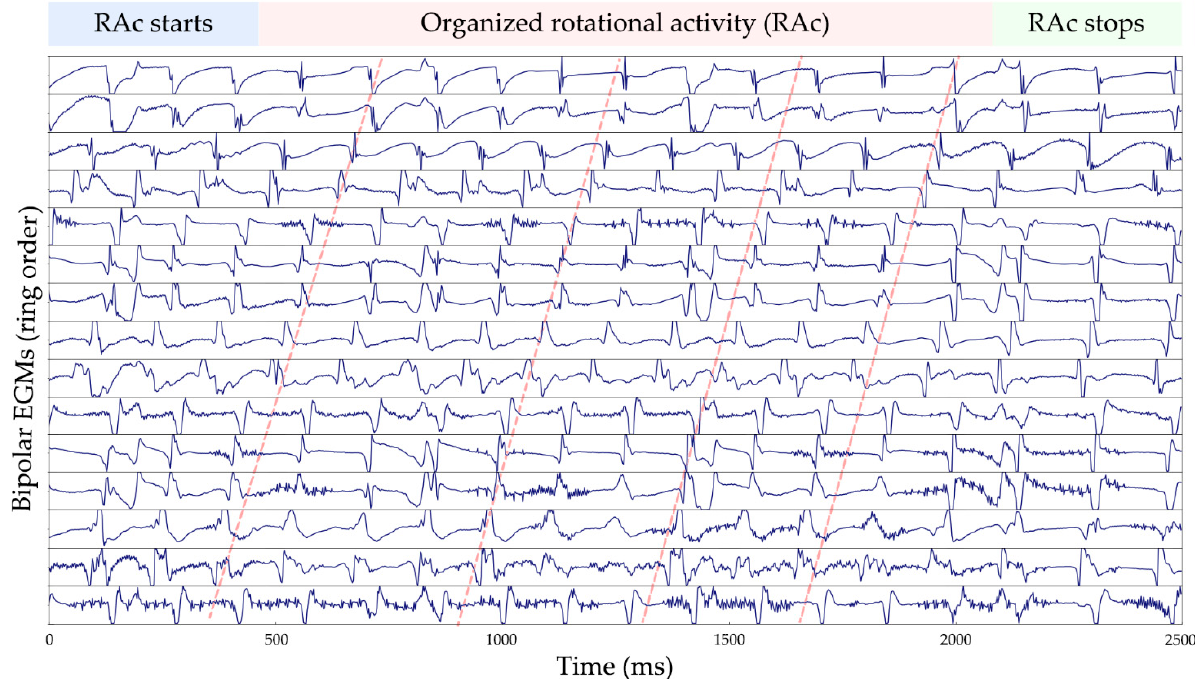
Figure 4. Example of an undetected rotor with CartoFinder in bipolar EGMs. The CRNN labeled this signal as a false positive, which later, after an expert inspection, was reclassified as a correctly detected rotational activity. CRNN, convolutional recurrent neural network; EGMs, electrograms; RAc, rotational activity.